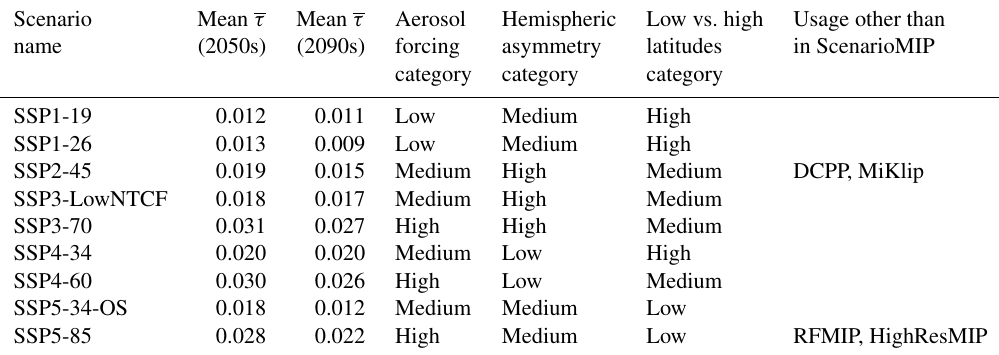
Table 2. Anthropogenic aerosol scenarios for MACv2-SP ( τ = 0 . 025 in 2015).